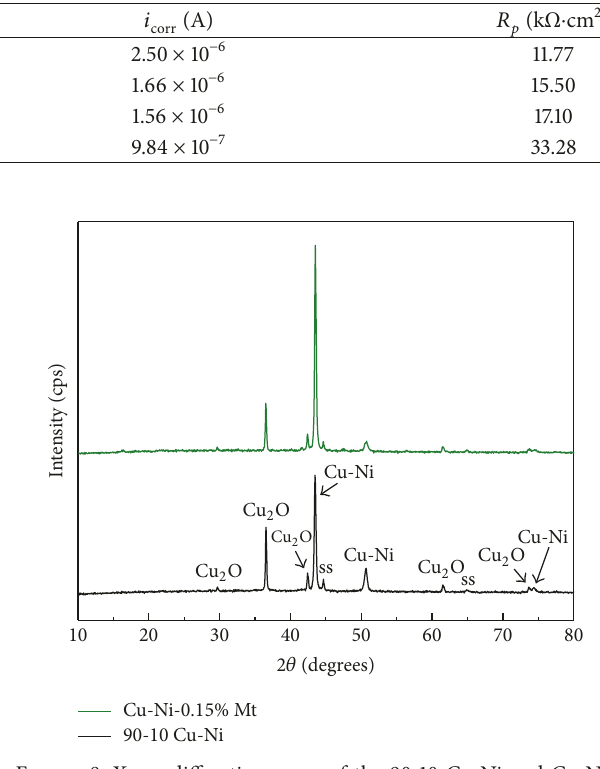
Figure 7: Potentiodynamic polarization plots for the 90-10 Cu-Ni and Cu-Ni-Mt nanocomposite coatings after being immersed in Burkholder’s Formula B solution for 30 days.